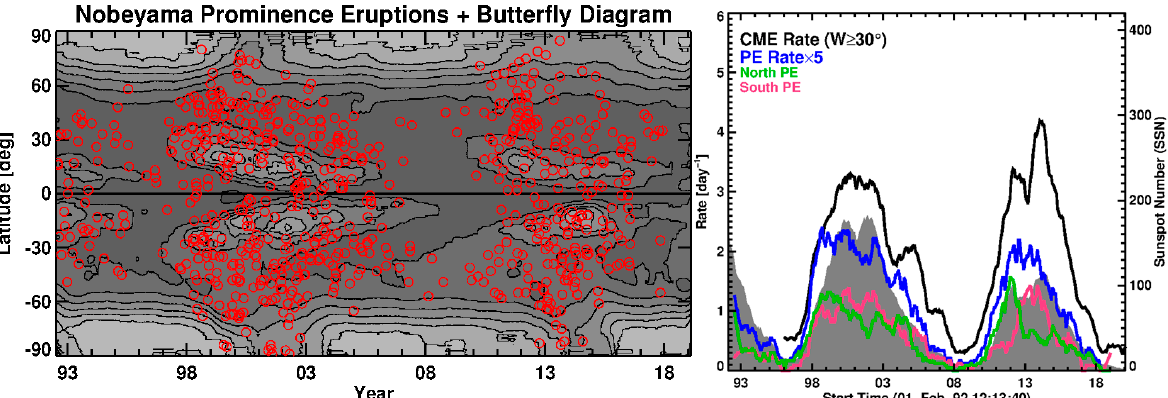
Figure 22. ( left ) Microwave butterfly diagram (contours) showing the 17 GHz brightness temperature at low latitudes due to active regions and at high latitudes due to the polar magnetic field. The red circles represent locations of prominence eruptions detected automatically in 17 GHz images of the Sun. ( right ) Comparison between CME and prominence eruption (PE) rates. The PEs from the Northern and Southern Hemispheres are distinguished by different colors. The gray plot in the background is the smoothed sunspot number. The CME and PE rates have been smoothed over 13 Carrington rotations.